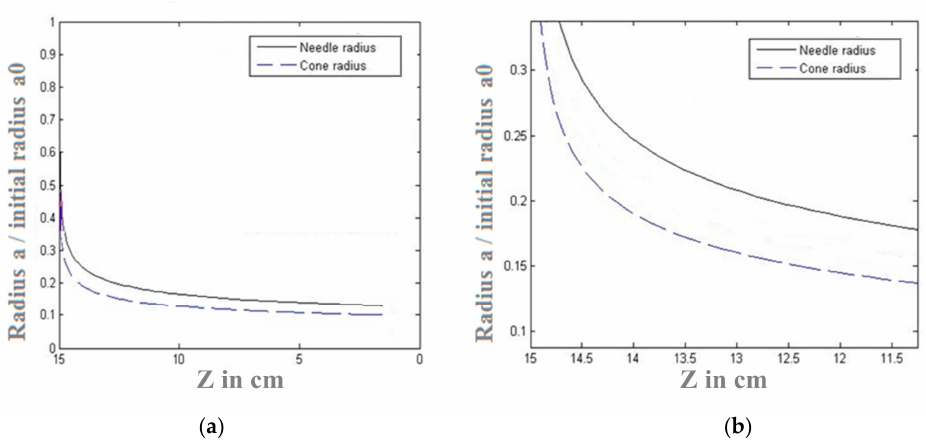
Figure 6. ( a ) Simulation results of radius of nanofibers relative change with distance due to both conical and needle feeders, with zoomed curves in ( b ).